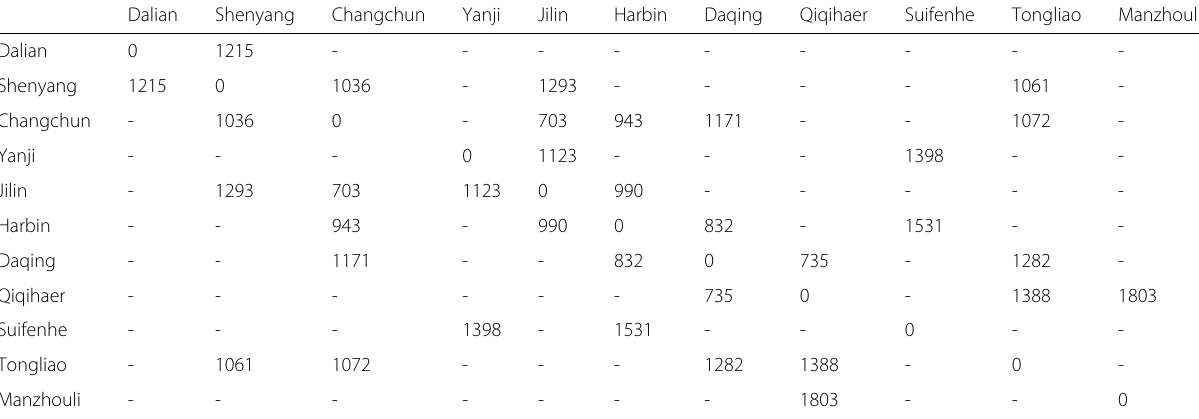
Table 5 Unit cost of a heavy container in railway transport